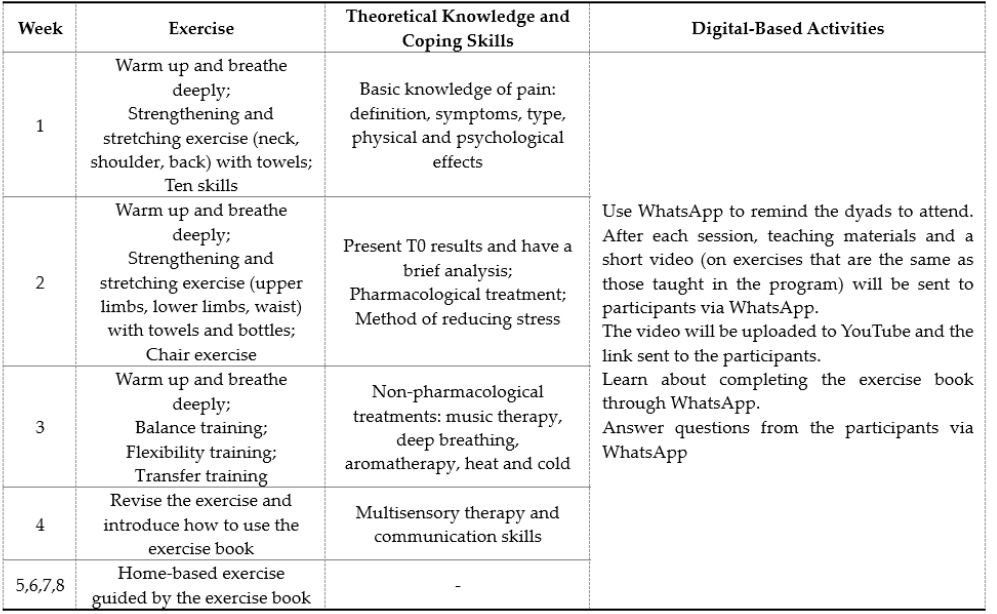
Figure 2. The contents of the dyadic pain management program (DPMP).